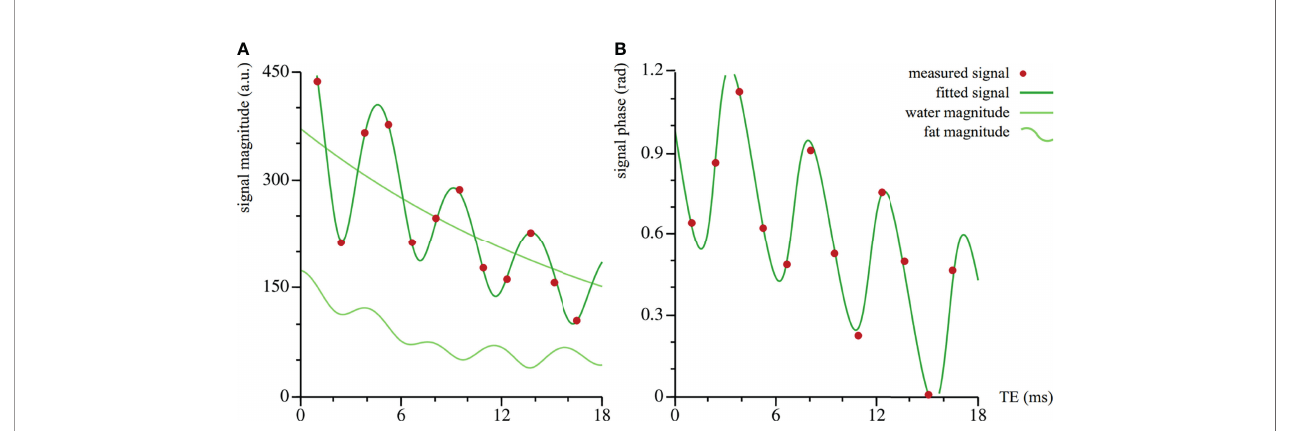
FIGURE 1 | Dataset and corresponding fi t of vertebra Th11 of volunteer #20. The fi t is performed on the complex valued data: the magnitude (arbitrary units) in (A) , the phase (radians) in (B) . The amplitude in the total signal magnitude is larger than in the fat component only, because of the interference of the fat and water signals.